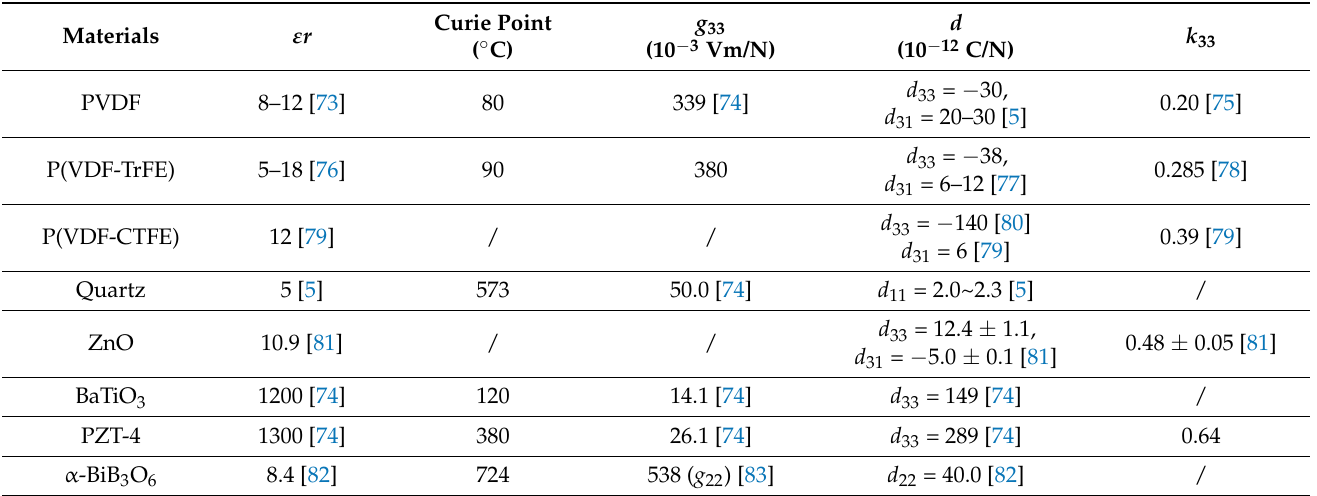
Table 2. Performance comparison of PVDF and its copolymers with inorganic